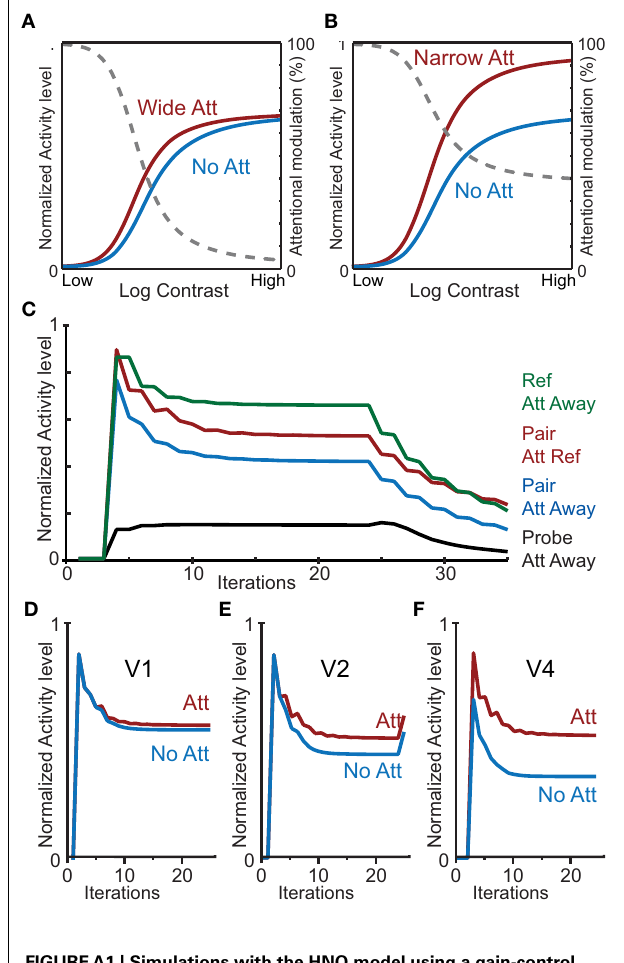
FIGUREA1 | Simulations with the HNO model using a gain-control implementation of feedback modulation rather than an additive mechanism. All simulations show results that are qualitatively similar to those obtained with additive feedback ( Figure 7 ). (A,B) Contrast dependency of a neuron responsive to a stimulus inV4 dependent on attention field size. (A) An attention field that is large (width of 30) compared to the stimulus (width of 3). (B) Identical to (A) , but with an attention field that is small (width of 3) compared to the stimulus (width of 5). (C) Simulation of a neuron’s response over time as measured by Reynolds et al. (1999), Figure 6 . (D,E,F) Simulation of progression of the attention effect as measured by Buffalo et al. (2010). Progression of attentional modulation overV1 (D) ,V2 (E) , andV4 (F) . All lines and colors are identical to the ones used in Figure 7